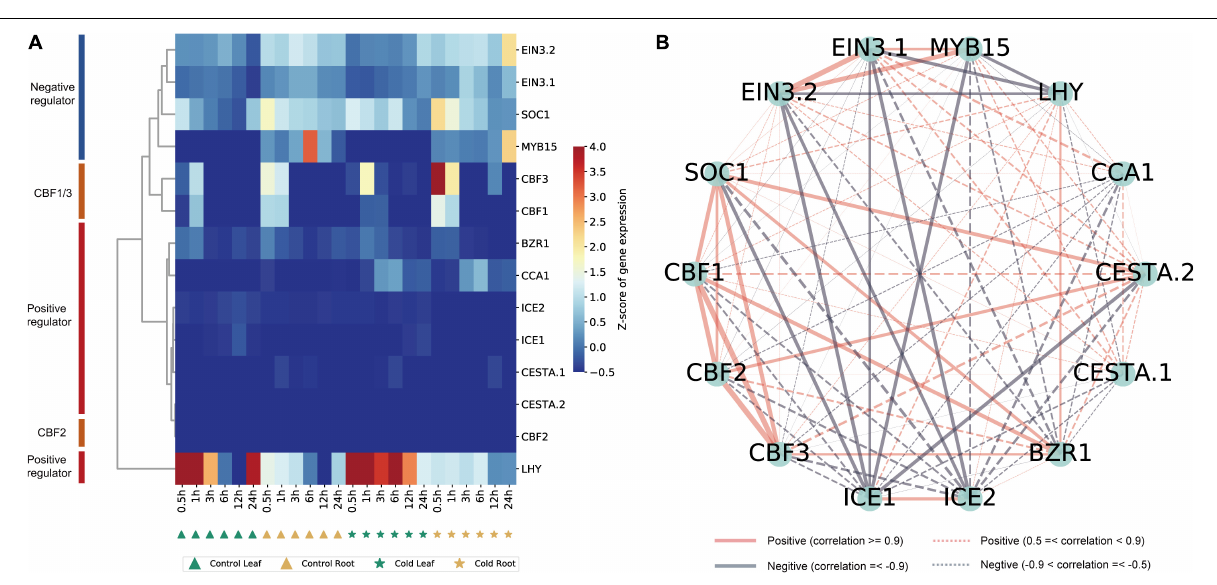
FIGURE 7 | Identification of ICE-CBF-COR genes in pepper and visualization of their co-expression network. (A) Hierarchical cluster analysis of 14 ICE-CBF-COR genes. The values in the heatmap represent the z -scores of transcripts per million (transcription level) in different samples. The red and blue colors indicate a high and low expression level, respectively. (B) Visualization of the 14 ICE-CBF-COR gene co-expression networks using the Python NetworkX